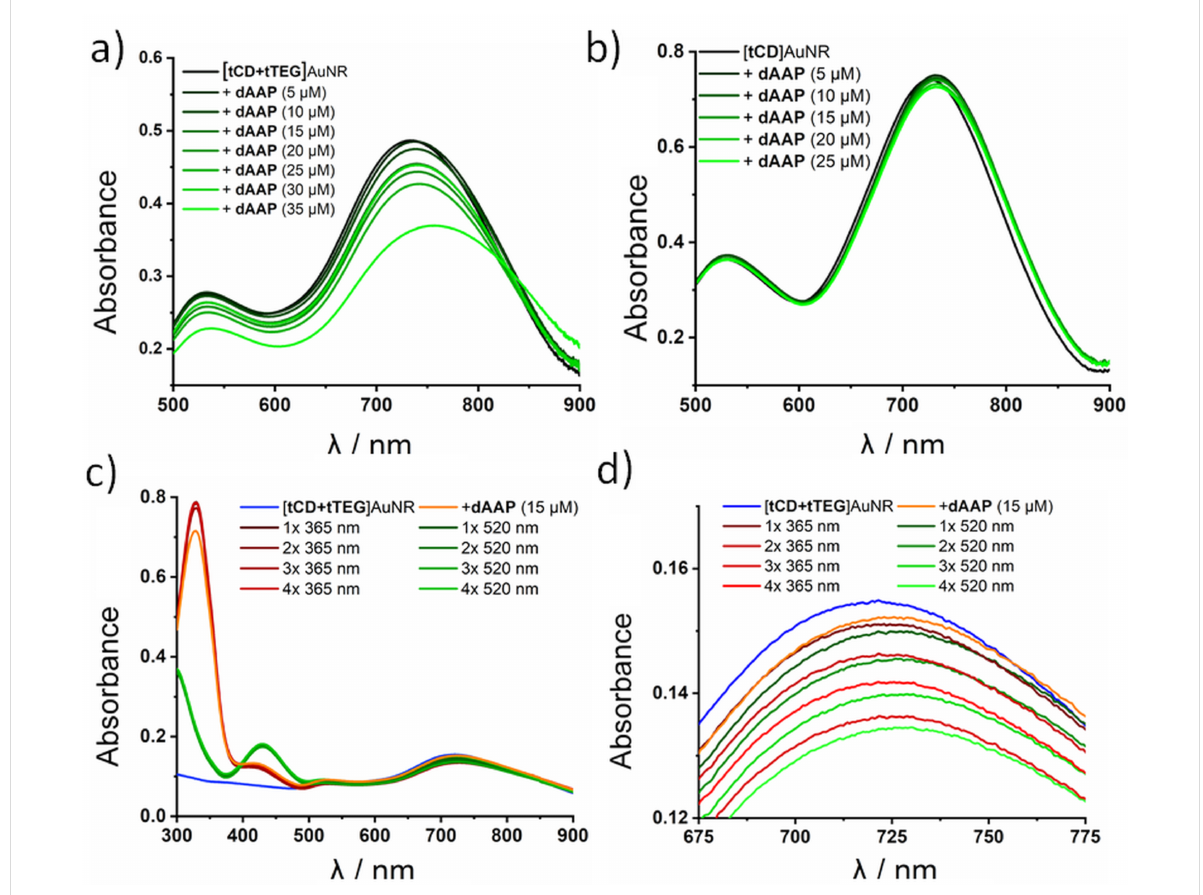
Figure 2: UV–vis spectroscopy of a) [tCD+tTEG]AuNR with different amount of dAAP (0-35 µM). b) [tCD]AuNR with dAAP (0–25 µM). c) [tCD+tTEG]AuNR with dAAP (15 µM). Assembly and disassembly by irradiation (5 min, 3 W lamp, λ = 360 nm and λ = 520 nm) over four cycles. d) Zoomed-in region of the